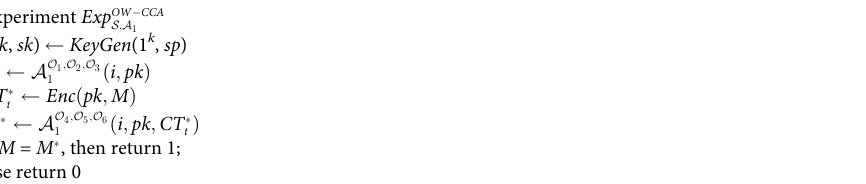
Table 1. The security model of Type-1